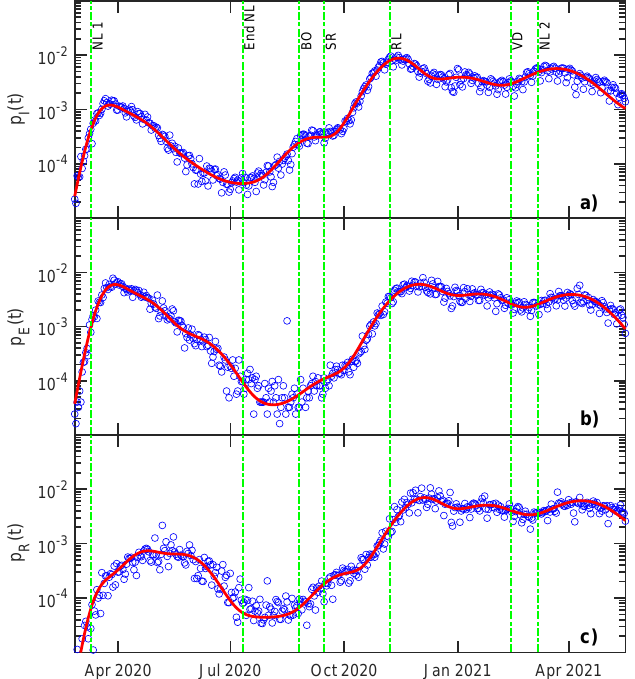
Figure 6. ( a ) Infected, ( b ) deceased and ( c ) recovered probability distribution functions. Blue open circles correspond to raw data, while the red solid lines represent model curves (Equations (26)–(28)). We underline that raw data series have been estimated by normalizing